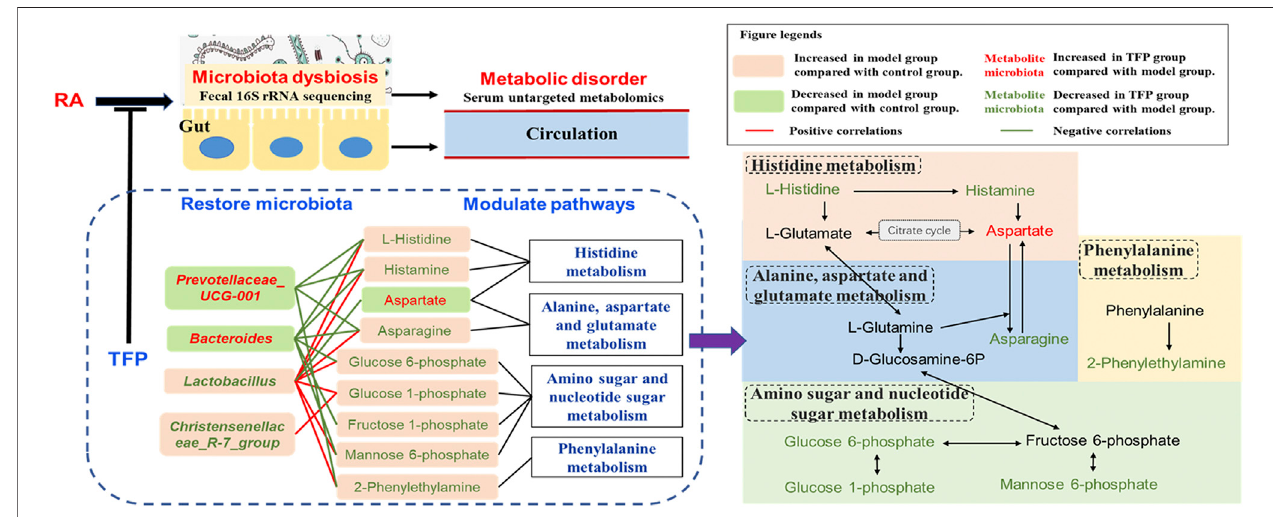
FIGURE 5 | Schematic diagram of TFP ’ s mechanism based on modulation of gut Microbiota and metabolic pathways.